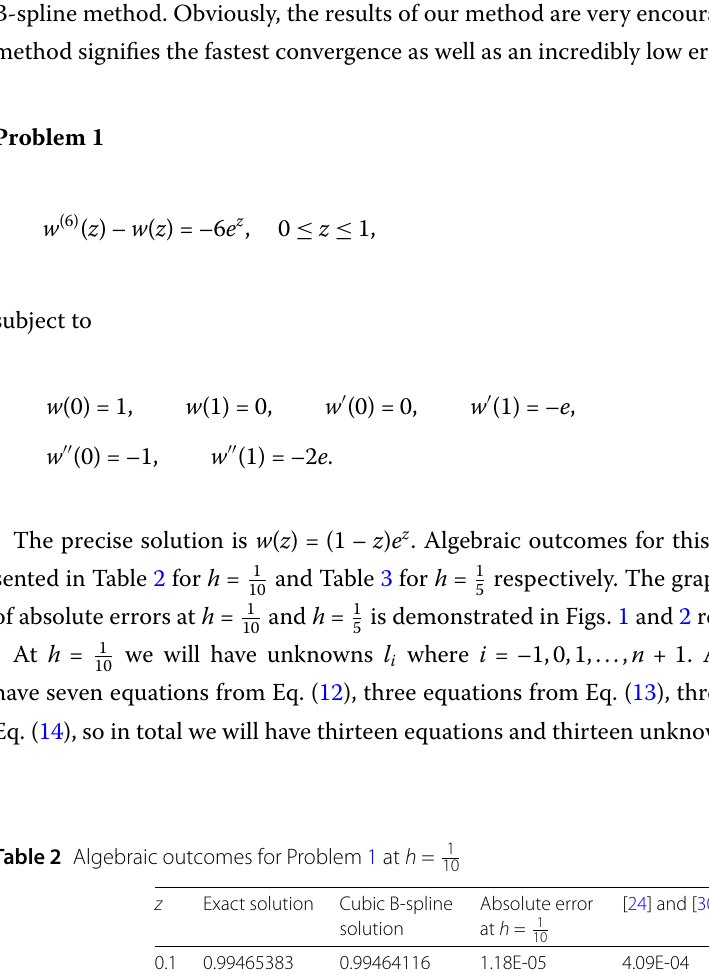
Exact solution Cubic B-spline solution